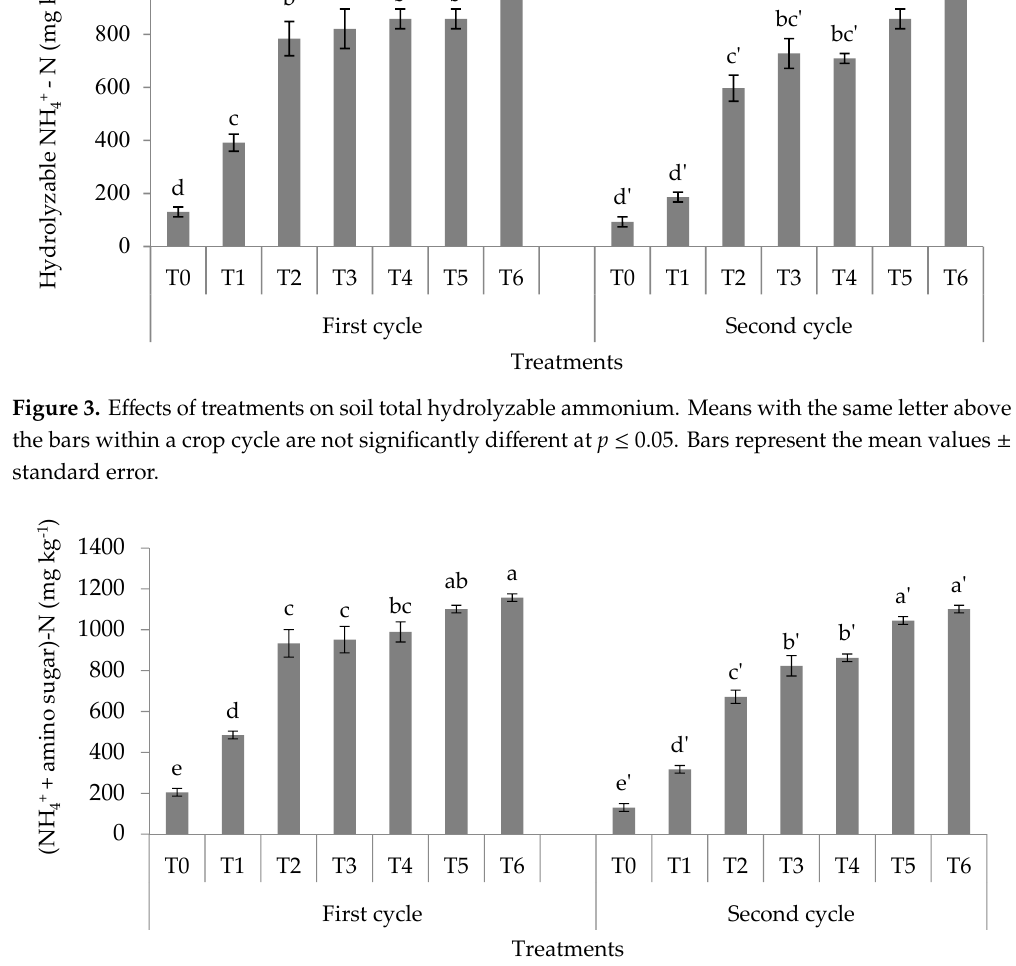
Figure 4. Effects of treatments on soil (ammonium + amino sugar)-nitrogen. Means with the same letter above the bars within a crop cycle are not significantly different at p ≤ 0.05. Bars represent the mean values ± standard error .